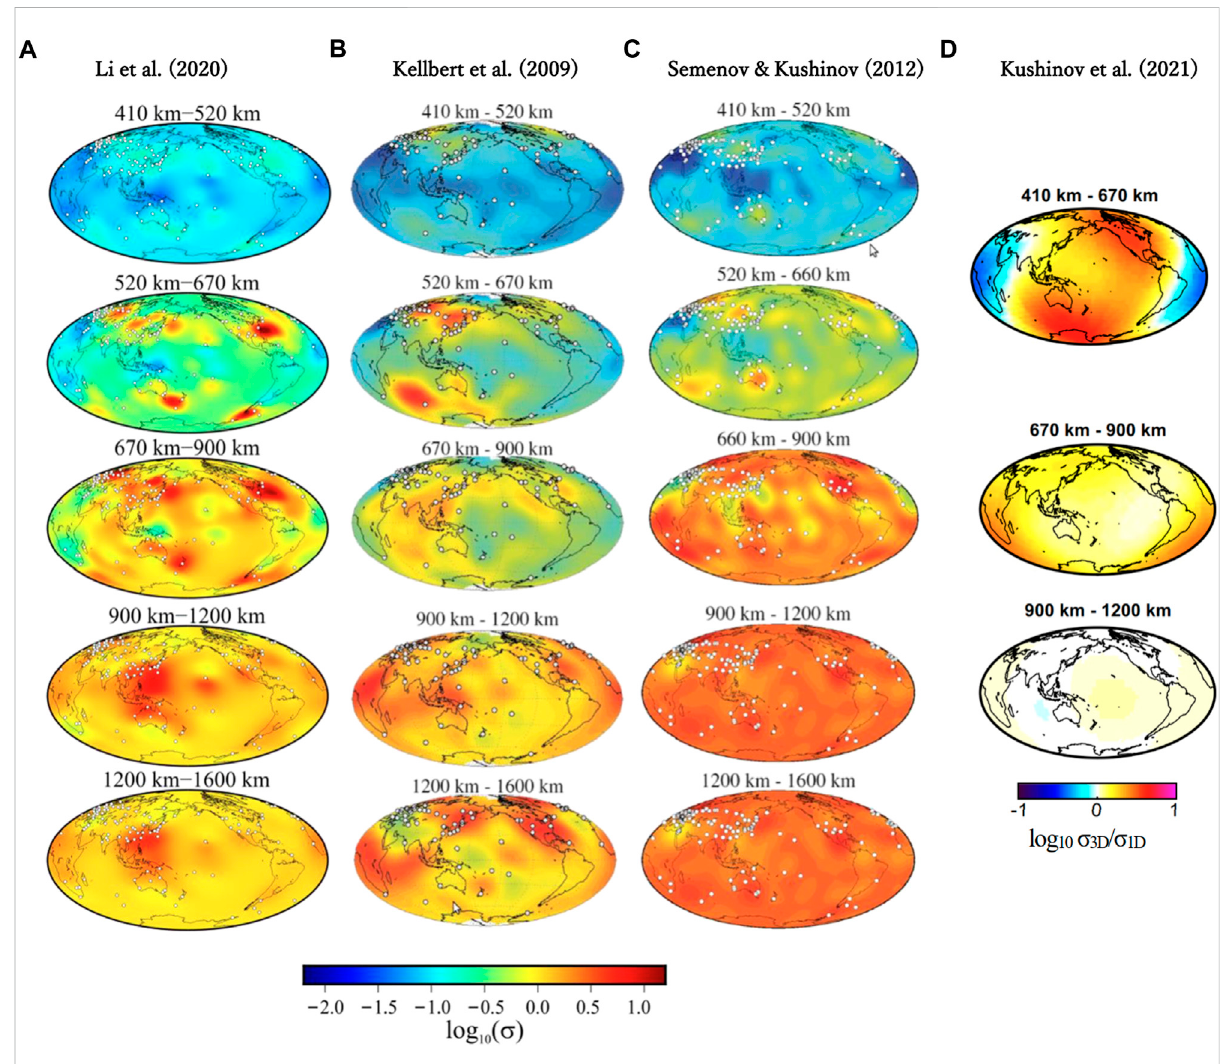
FIGURE 3 Global electrical conductivity models. (A) Li et al. (2020), (B) Kelbert et al. (2009), (C) Semenov and Kuvshinov (2012), and (D) Kuvshinov et al. (2021). The result of Kuvshinov et al. (2021) is expressed as deviation in logarithmic scale from the 1D background conductivity at each depth